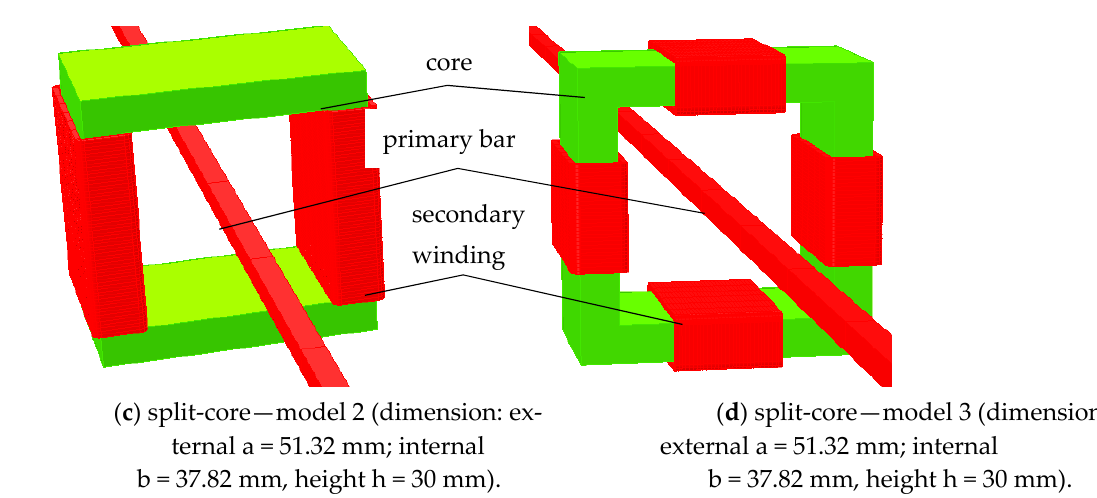
( c ) split-core—model 2 (dimension: ex- Figure 1. ( a – d ) 3D geometrical models of the measuring current transformers 600 A/5 A (number of turns = 120). Figure 1. ( a – d ) 3D geometrical models of the measuring current transformers 600 A/5 A (number of turns = 120). Figure 1. ( a – d ) 3D geometrical models of the measuring current transformers 600 A/5 A (number of turns = 120).